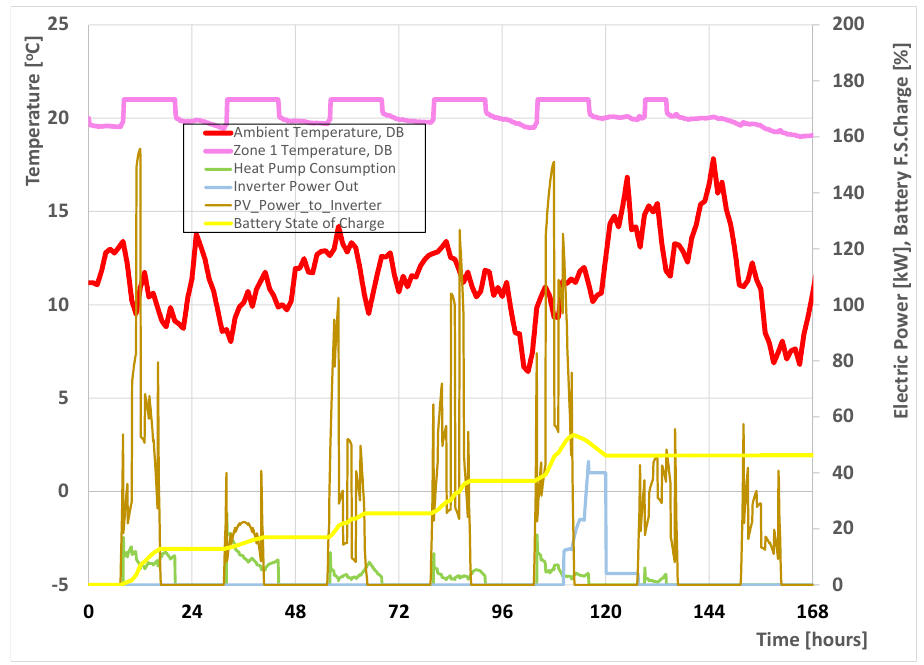
Figure 7. Ambient temperature, room temperature, heat pump electricity consumption, and PV inverter’s outlet power in the first week of January. The conditioned zone temperatures are kept at the setpoint of 20 °C as seen by the example of Zone 1. The batteries, assumed to start from zero charging levels, reached 50% of their total aggregate capacity, since all the building’s needs are covered by importing electricity from the grid.